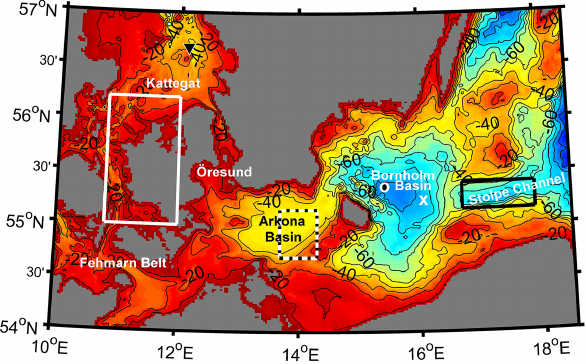
Figure 1. Map of the southern Baltic Sea area (hypsographic data from Seifert et al., 2001). Reference data for the Arkona Basin orig- inate from the area within the white and black dashed rectangle, and reference data stations BY4 and BY5 in the Bornholm Basin are marked by a white o and x, respectively. Data from the Stolpe Channel used for forcing of the model originate from the area within the black rectangle. The forcing data for the freshwater pool model were obtained from within the white rectangle and from the Anholt E station marked by (cid:72)